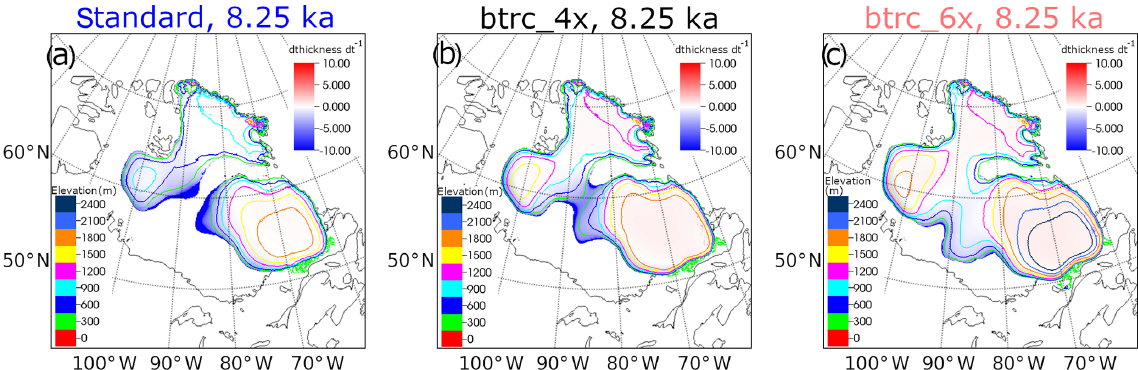
Figure 8. Modelled ice thickness and rate of change in thickness (ma − 1 ) at 8.25ka in (a) the standard simulation, (b) the btrc_4x simulation in which the standard basal traction coefficient field is quadruple and (c) btrc_6x in which the standard basal traction coefficient field is multiplied by 6.